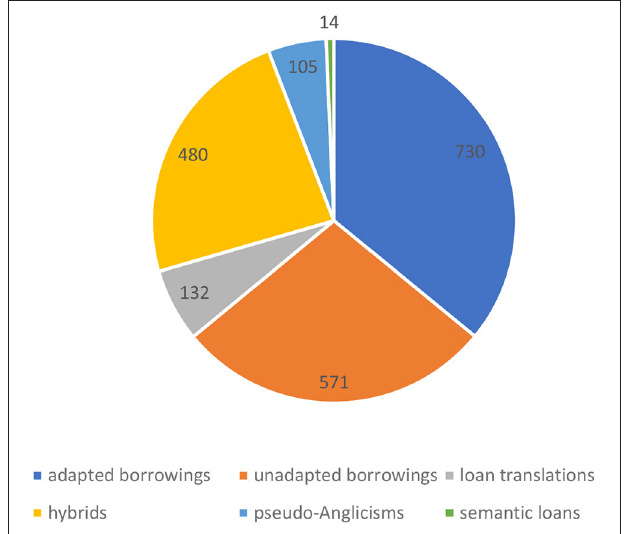
FIGURE 3 | Types of borrowings.